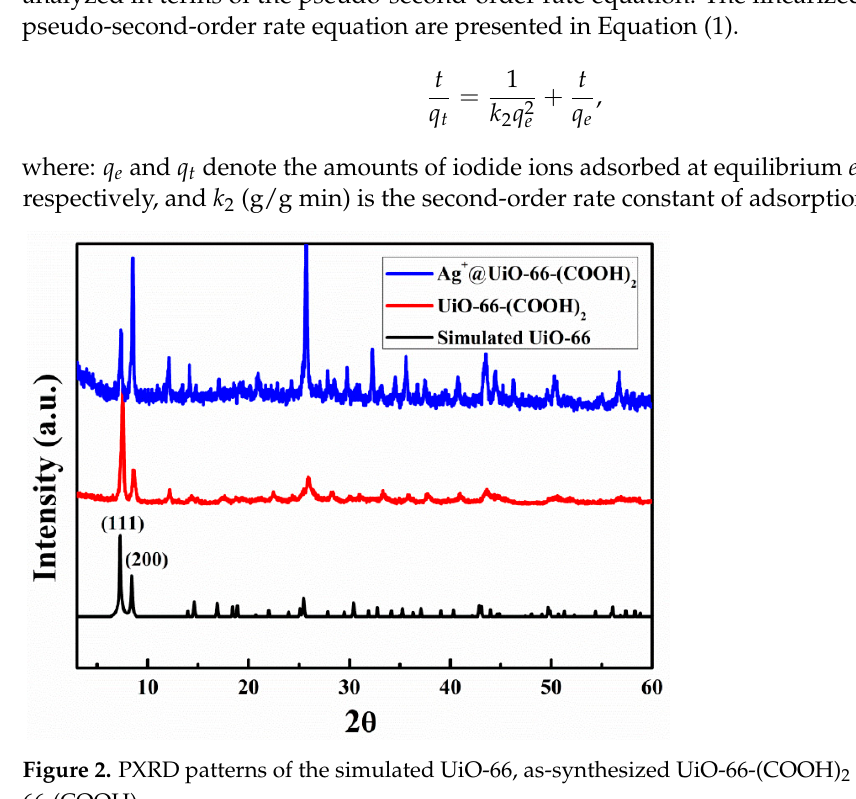
Figure 4. ( a ) Effect of initial concentration on the adsorption of I − by Ag + @UiO-66-(COOH) 2 ; ( b ) Langmuir isotherm models for the adsorption of I − . Furthermore, the complex exhibits outstanding adsorption behavior to I − in diverse interference ions. Commonly, contaminated water contains several anions, including ni- trate (NO 3 − ), nitrite (NO 2 − ), sulphate (SO 42 − ), and fluoride (F − ), which may cause hindrance in the capture of I − . To check this, the removal of I − was tested using a binary mixture of anions (0.5 g/L I − and 1 × 10 − 2 M, other competing ions including NO 3 − , NO 2 − , SO 42 − , and F − ) by ion chromatography. At room temperature, the standard curve of iodide in aqueous